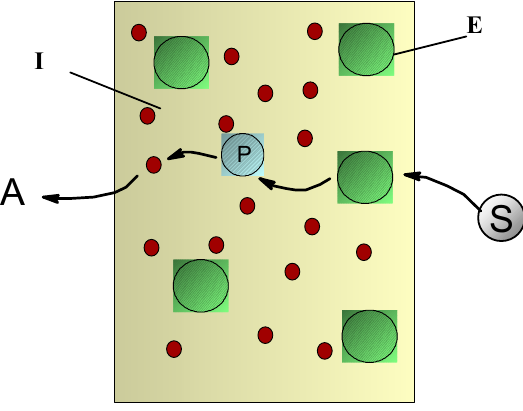
FIGURE 5 . Schematic representation of the processes running on the membrane with immobilized indicator and enzyme when the substrate urea is